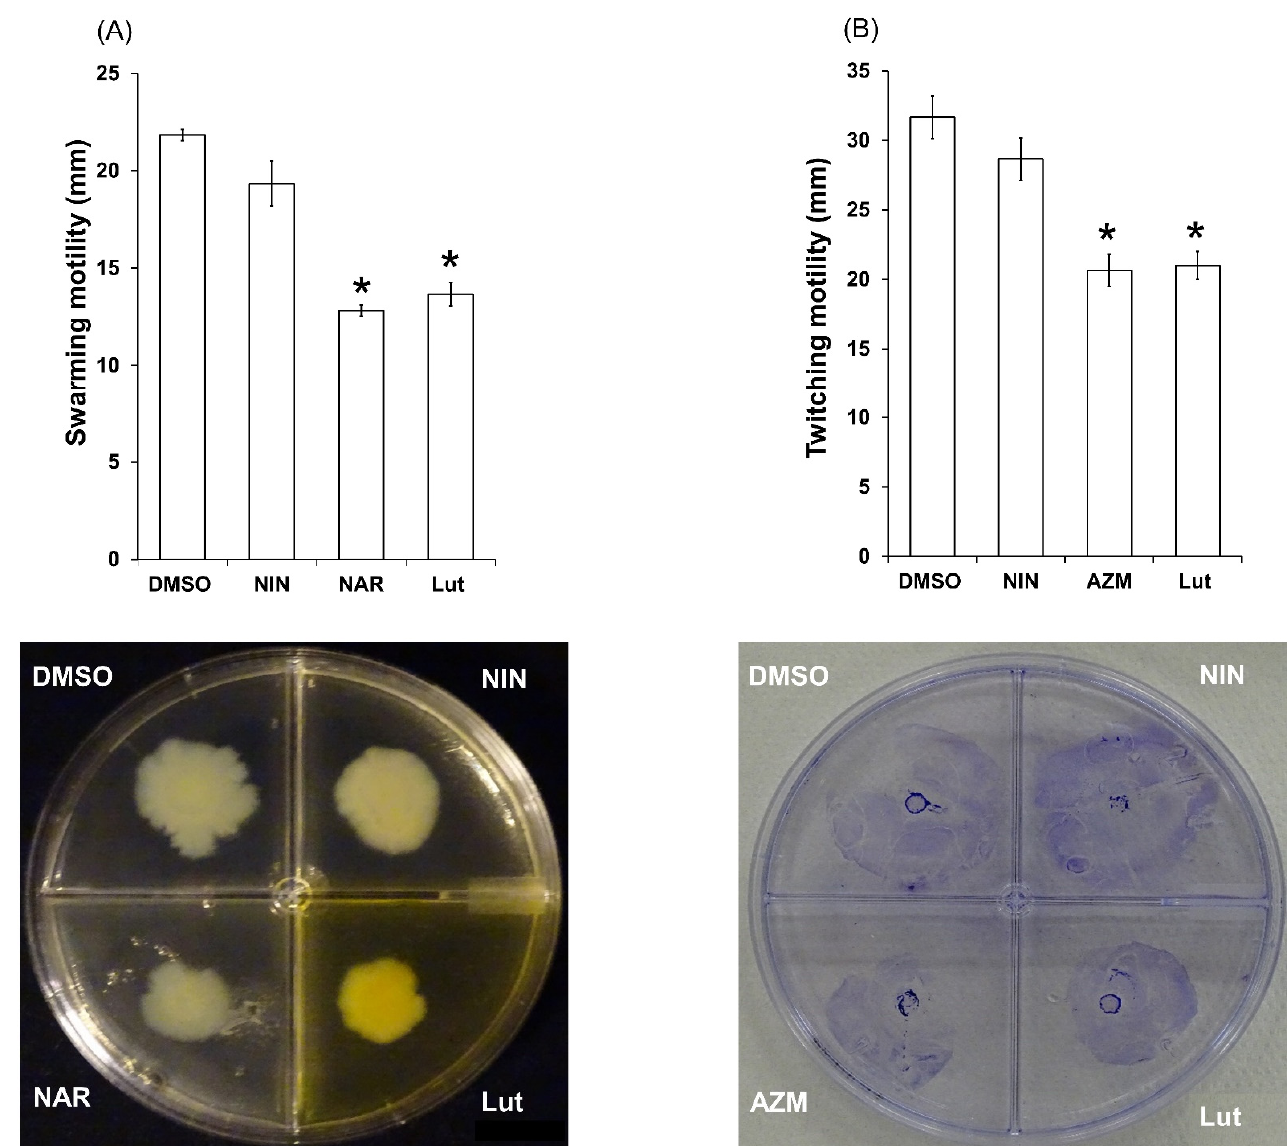
Figure 6. Effect of Lut on P. aeruginosa PAO1 motilities ( A ) swarming ability of PAO1 onto LB agar (0.6%) supplemented with glutamate (0.05%) and glucose (0.2%) as well as DMSO (1%), Lut (22 µM final concentration), naringenin (NAR, 1 mM final concentration) or naringin (NIN, 1 mM final concentration). After incubation at 37 °C for 24 h, the zones of migration from the point of inoculation were measured for each condition and expressed in mm. ( B ) Twitching motility of PAO1 onto LB agar (1%) alone (LB) or supplemented with DMSO (1%), or Lut (22 µM final concentration), or azithromycin (AZM, 2.6 µM final concentration). The twitching zones were stained, and their diameters were measured and expressed in mm after incubation at 37 °C for 48 h. All experiments were performed in triplicate with three independent assays. Error bars represent the standard error of the mean and the asterisks indicate samples that are significantly different from control condition ( p ≤ 0.01).